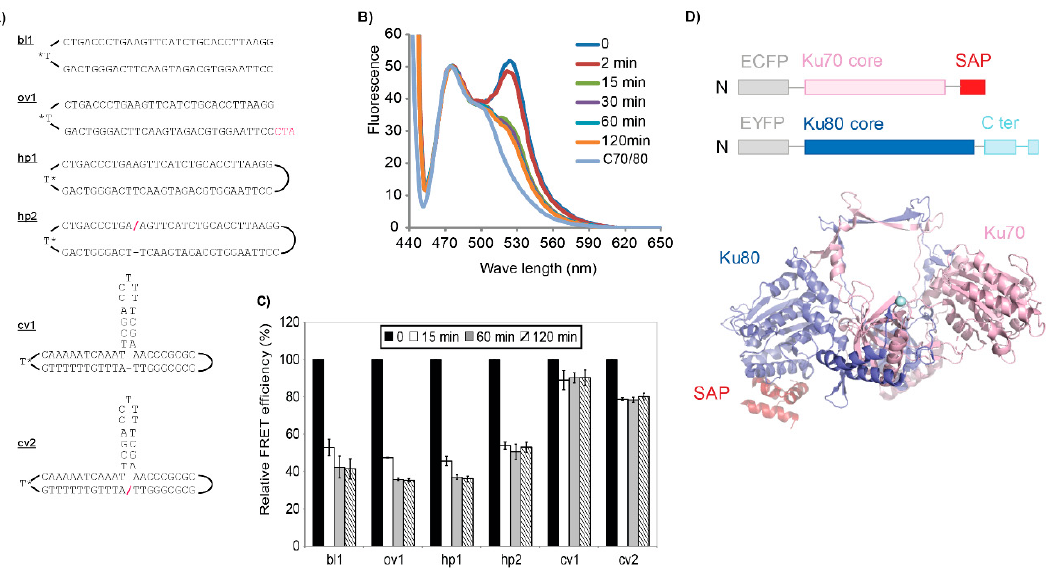
Figure 1. FRET (Forster resonance energy transfer) efficiency decreases upon Ku-DNA binding. ( A ) Schematic of the substrates; the difference between substrates hp1/hp2 and cv1/cv2 is the presence of a nick in substrates hp2 and cv2 (depicted by a red/-sign); T* = biotinylated T. ( B ) FRET efficiency (525 nm peak) decreased in time upon addition of substrate ov1. C70/80 = ECFP (enhanced cyan fluorescent protein) spectrum derived from ECFP-Ku70/Ku80. ( C ) Quantification of relative FRET efficiency after the addition of the indicated oligonucleotide substrates (access from the biotinylated T was blocked by the addition of streptavidin). Error bars depict the standard error of the mean (SEM). ( D ) Top: Schematic representation of the fluorescently tagged Ku70 and Ku80 polypeptides. Bottom: Cartoon representation of the Ku heterodimer (1JEQ.pdb [5]) with core Ku70 domain in pink, SAP domain in red, core Ku80 domain in blue, and the location of the Ku80 C-terminal extension indicated with the cyan sphere. DNA would be bound in the central cavity, resulting in